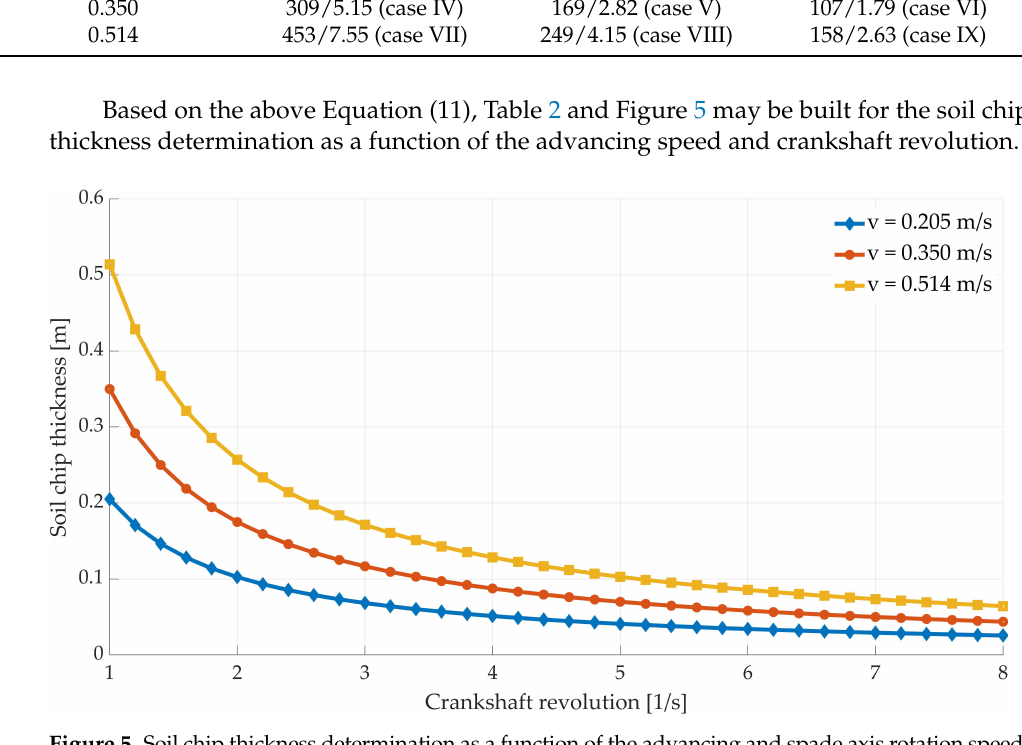
Figure 5. Soil chip thickness determination as a function of the advancing and spade axis rotation